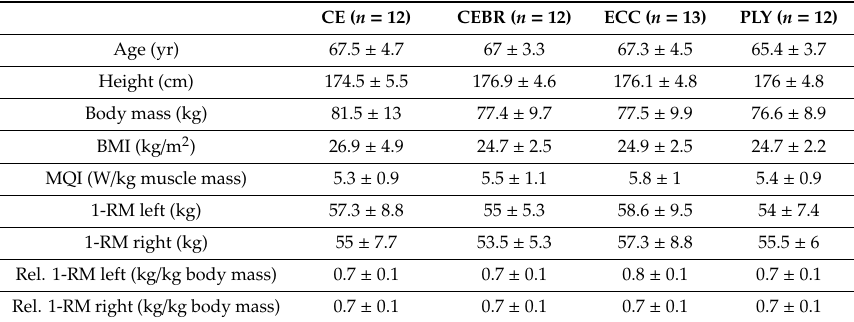
Table 1. Anthropometric characteristics, muscle quality and strength by exercise